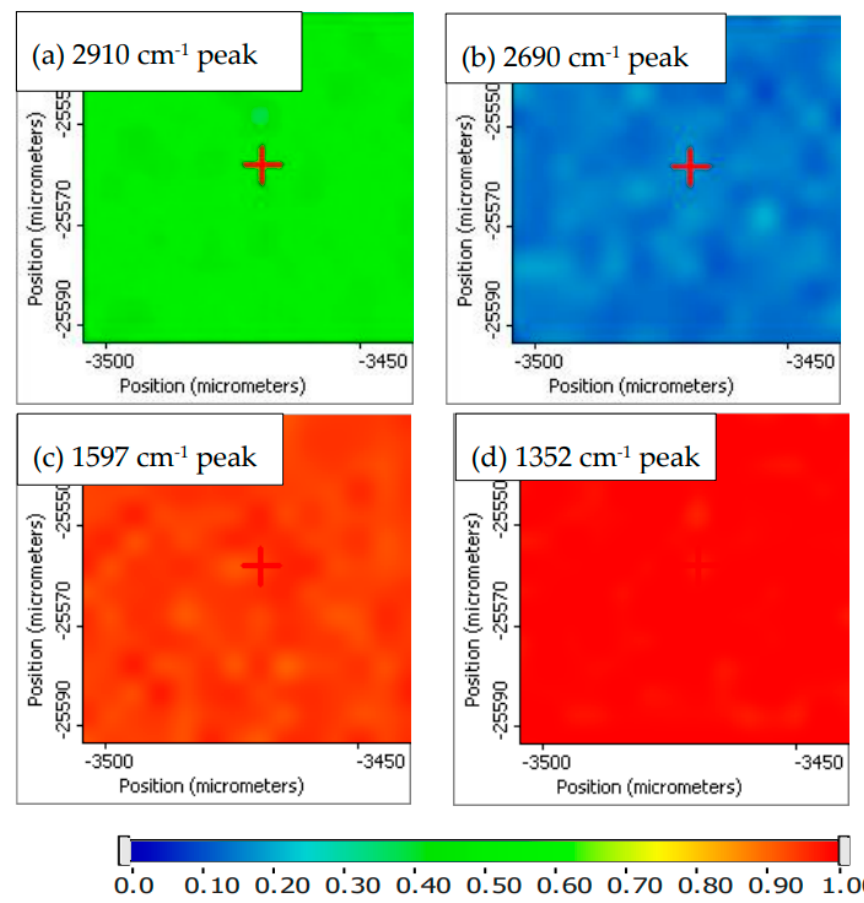
Figure 8. Raman images obtained using peak height profiling option of normalized Raman spectra for the PVA_GO_CNT_COOH membrane in a region of 65 um × 65 um. These images are the peak height distribution for ( a ) PVA, ( b ) CNT_COOH, ( c ) GO_CNT-COOH, and ( d ) GO_CNT_COOH in the composite hybrid membrane.